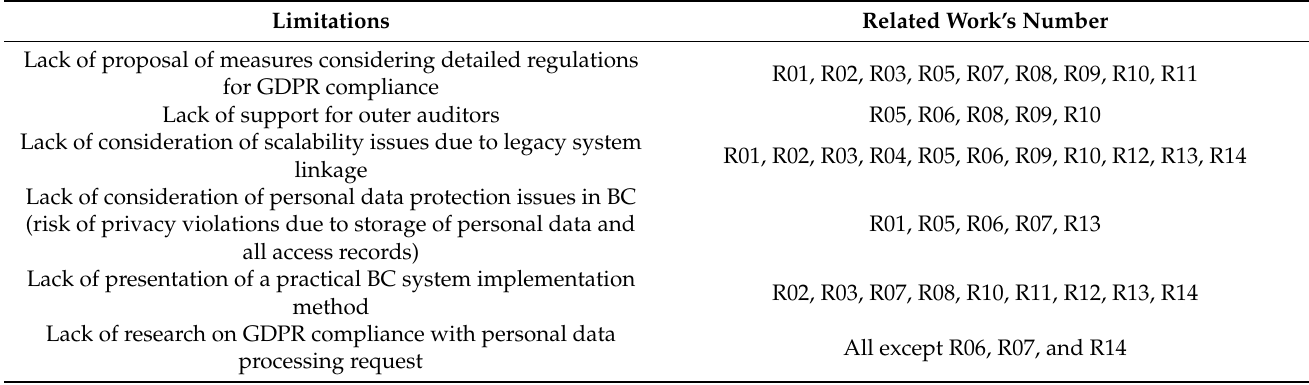
Table 3. The limitations of related works for GDPR compliance